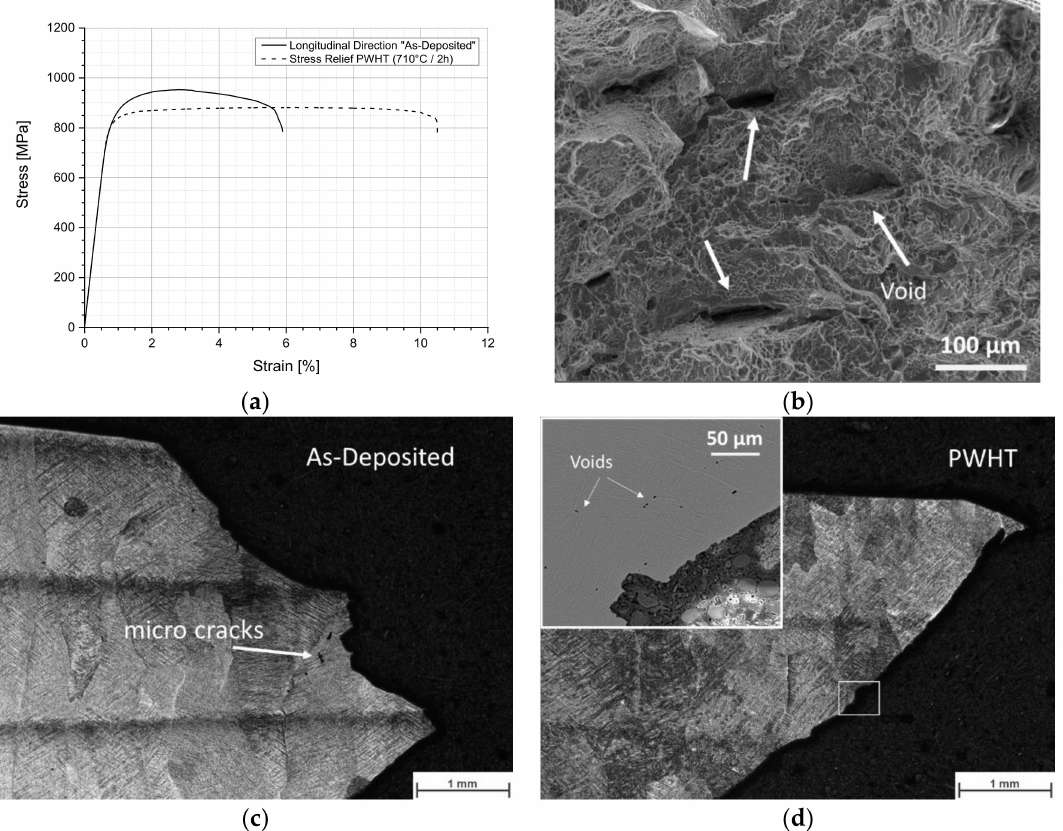
Figure 9. ( a ) Engineering stress–strain curves for longitudinal orientated tensile specimens. ( b ) Detail of the fracture surface for the PWHT condition. ( c , d ) Macrograph of the cross section of the fracture area of as-deposited and PWHT conditions,